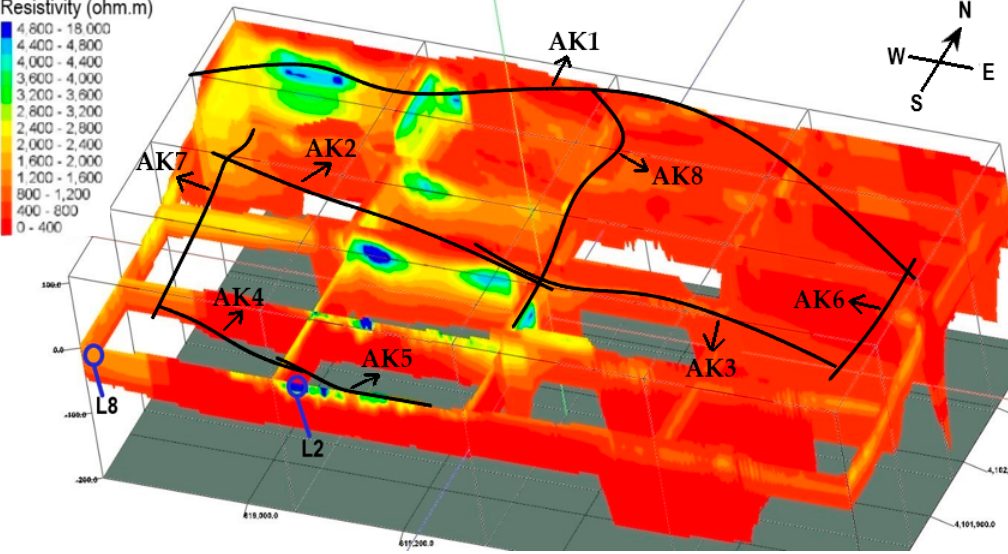
Figure 8. 3D resistivity model of the study area. L2 and L8 springs are shown in blue circles. View from top and southeast. Blue and its tones indicate the cavities.